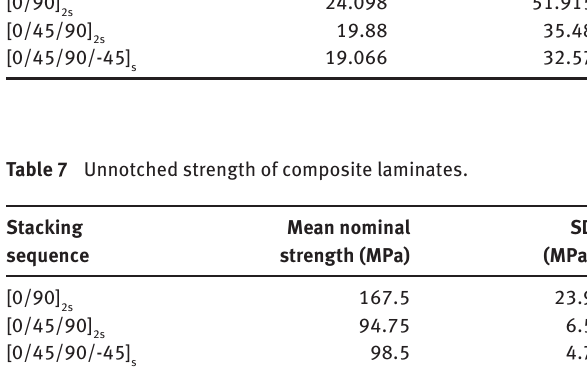
Figure 6 Typical load versus displacement